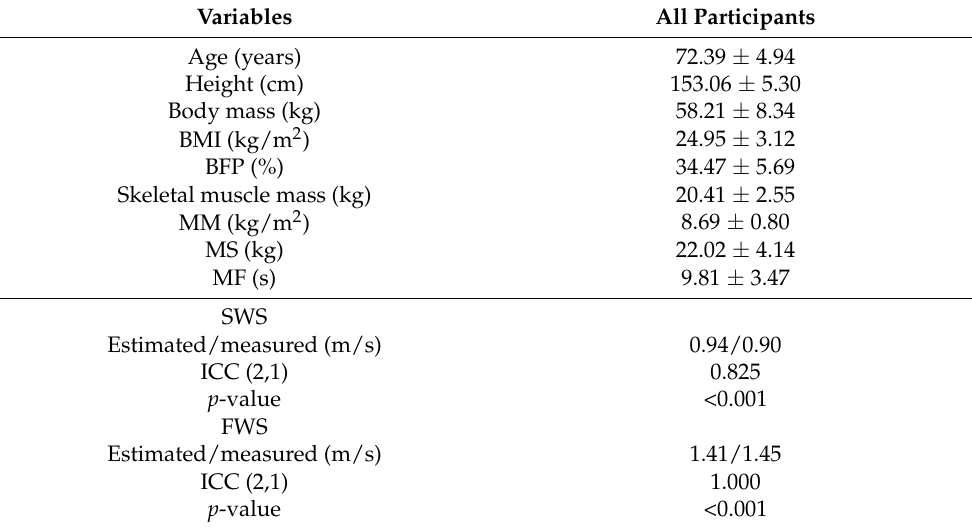
Table 1. Participants’ demographic and muscle-related characteristics ( n =